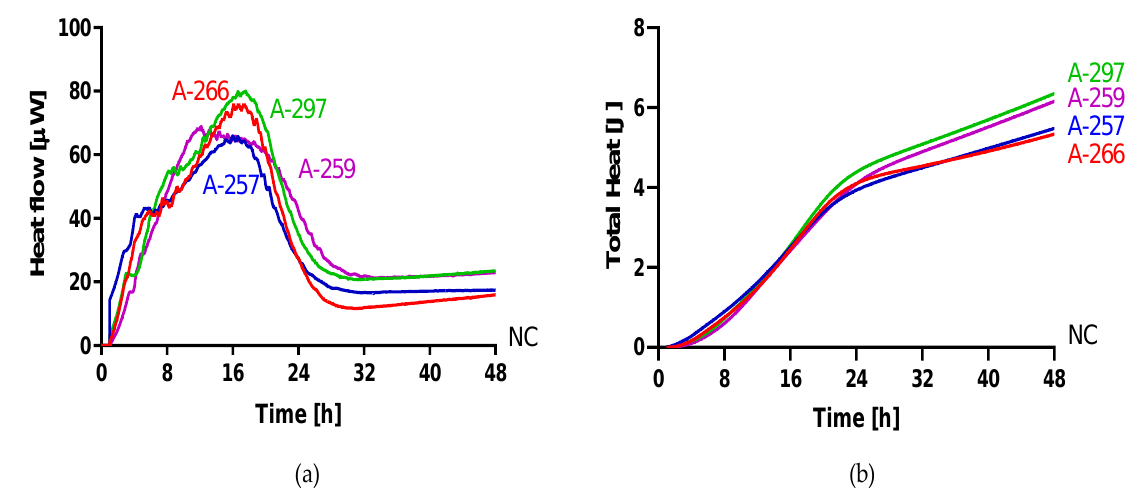
Figure 2. Microcalorimetry analysis of C. auris . Heat flow ( a ) and total heat ( b ) curves generated by planktonic C. auris 10051257, C. auris 10051259, C. auris 10051266, and C. auris 10051297 in RPMI 1640 at 37 °C.